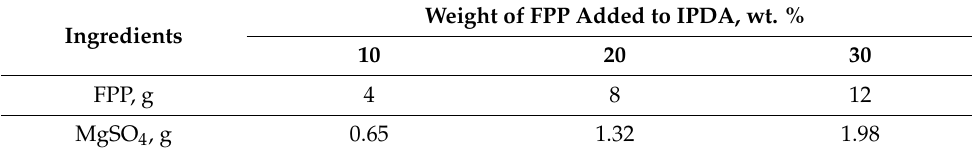
Table 1. Curing agent composition formulations.